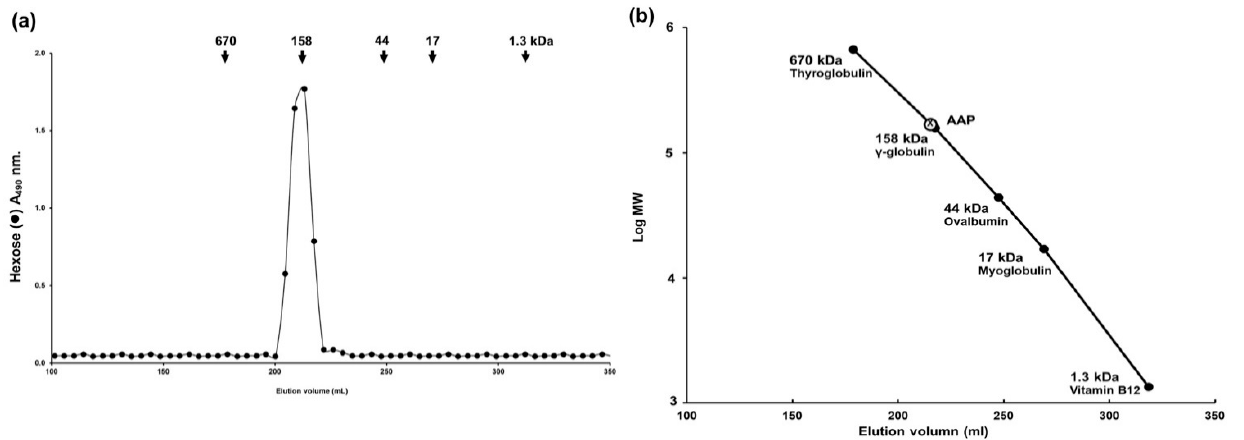
Figure 1 . Polysaccharide characteristics of A . auricula - judae ( AAP ). The molecular weight of the polysaccharides was de- Figure 1. Polysaccharide characteristics of A. auricula-judae (AAP). The molecular weight of the polysaccharides was termined by Sephacryl S - 400 gel filtration chromatography . ( a ) AAP was eluted with 0 . 2 M ammonium bicarbonate at a determined by Sephacryl S-400 gel filtration chromatography. ( a ) AAP was eluted with 0.2 M ammonium bicarbonate at a flow rate of 25 mL / h . The fractions were assayed for hexose sugars ( A490 nm ) , and the standard proteins are represented flow rate of 25 mL/h. The fractions were assayed for hexose sugars (A490 nm), and the standard proteins are represented by arrows to indicate molecular size ( kDa ). ( b ) The molecular weight was calculated using the calibration logMW curve by arrows to indicate molecular size (kDa). ( b ) The molecular weight was calculated using the calibration logMW curve of of standard proteins ( ranging from 1 . 3 – 670 kDa .). standard proteins (ranging from 1.3–670